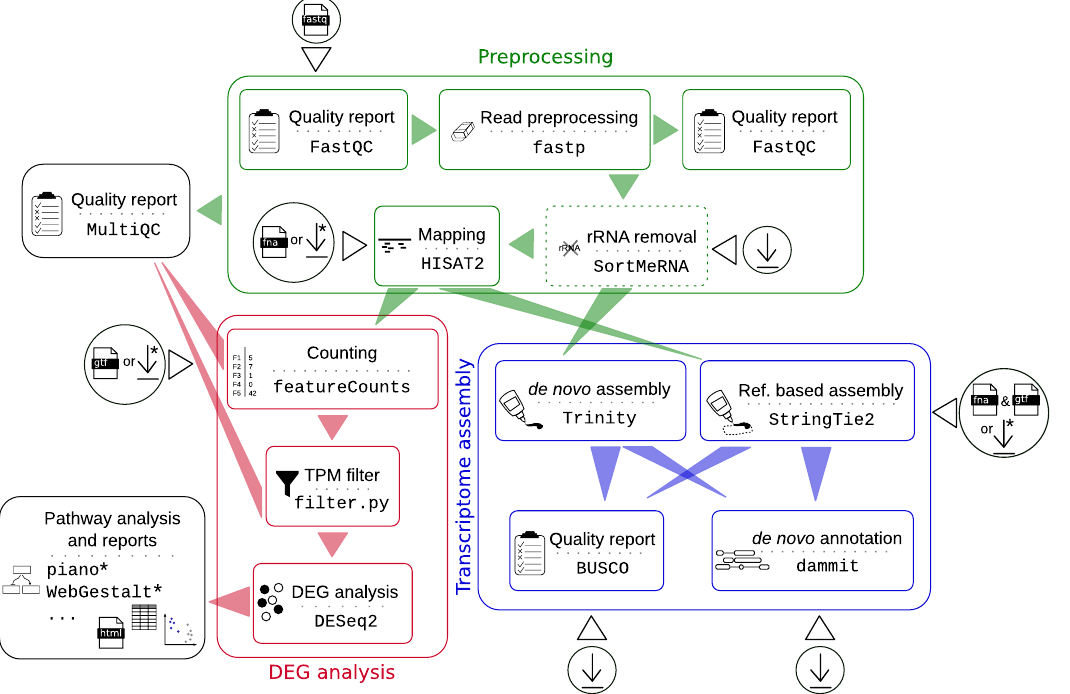
Figure 1. Workflow of the RNA-Seq pipeline. The user can decide after preprocessing to run a differential gene expression analysis or a transcriptome assembly. Circles symbolize input data and download icons symbolize automated download of resources. Steps marked by asterisks are currently only available for some species (see Implementation